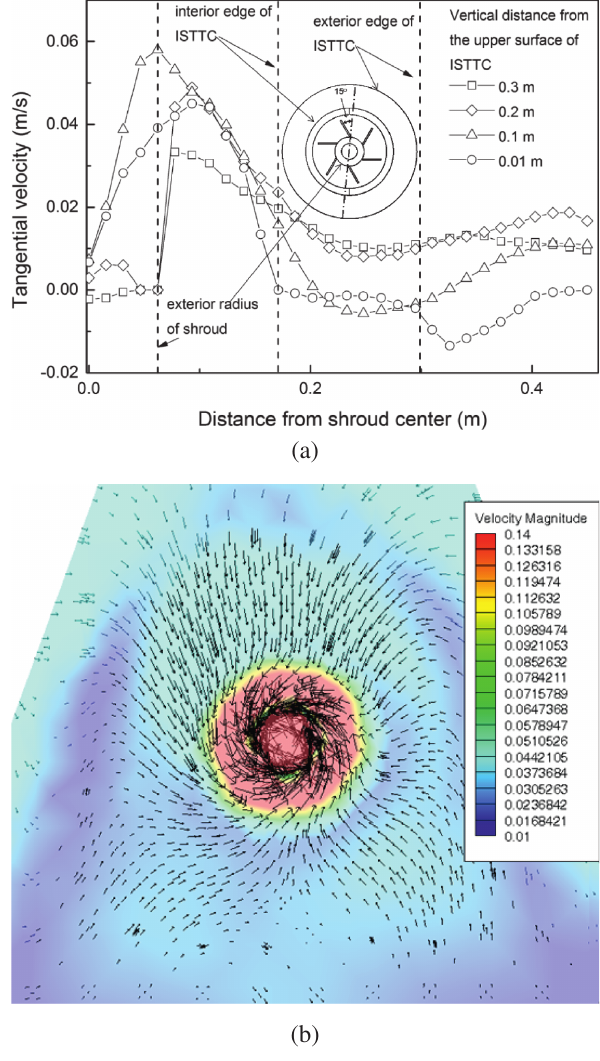
Figure 9: The tangential velocity distribution of zone above ISTTC with θ of 15°. (a) The tangential velocity distribution (b) The vector diagram of plane (h pl =